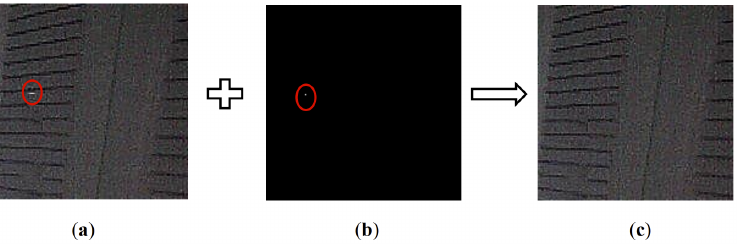
Figure 8. Block:4 process. ( a ) Block:4 input. ( b ) Block:4 mask image. ( c ) Block:4